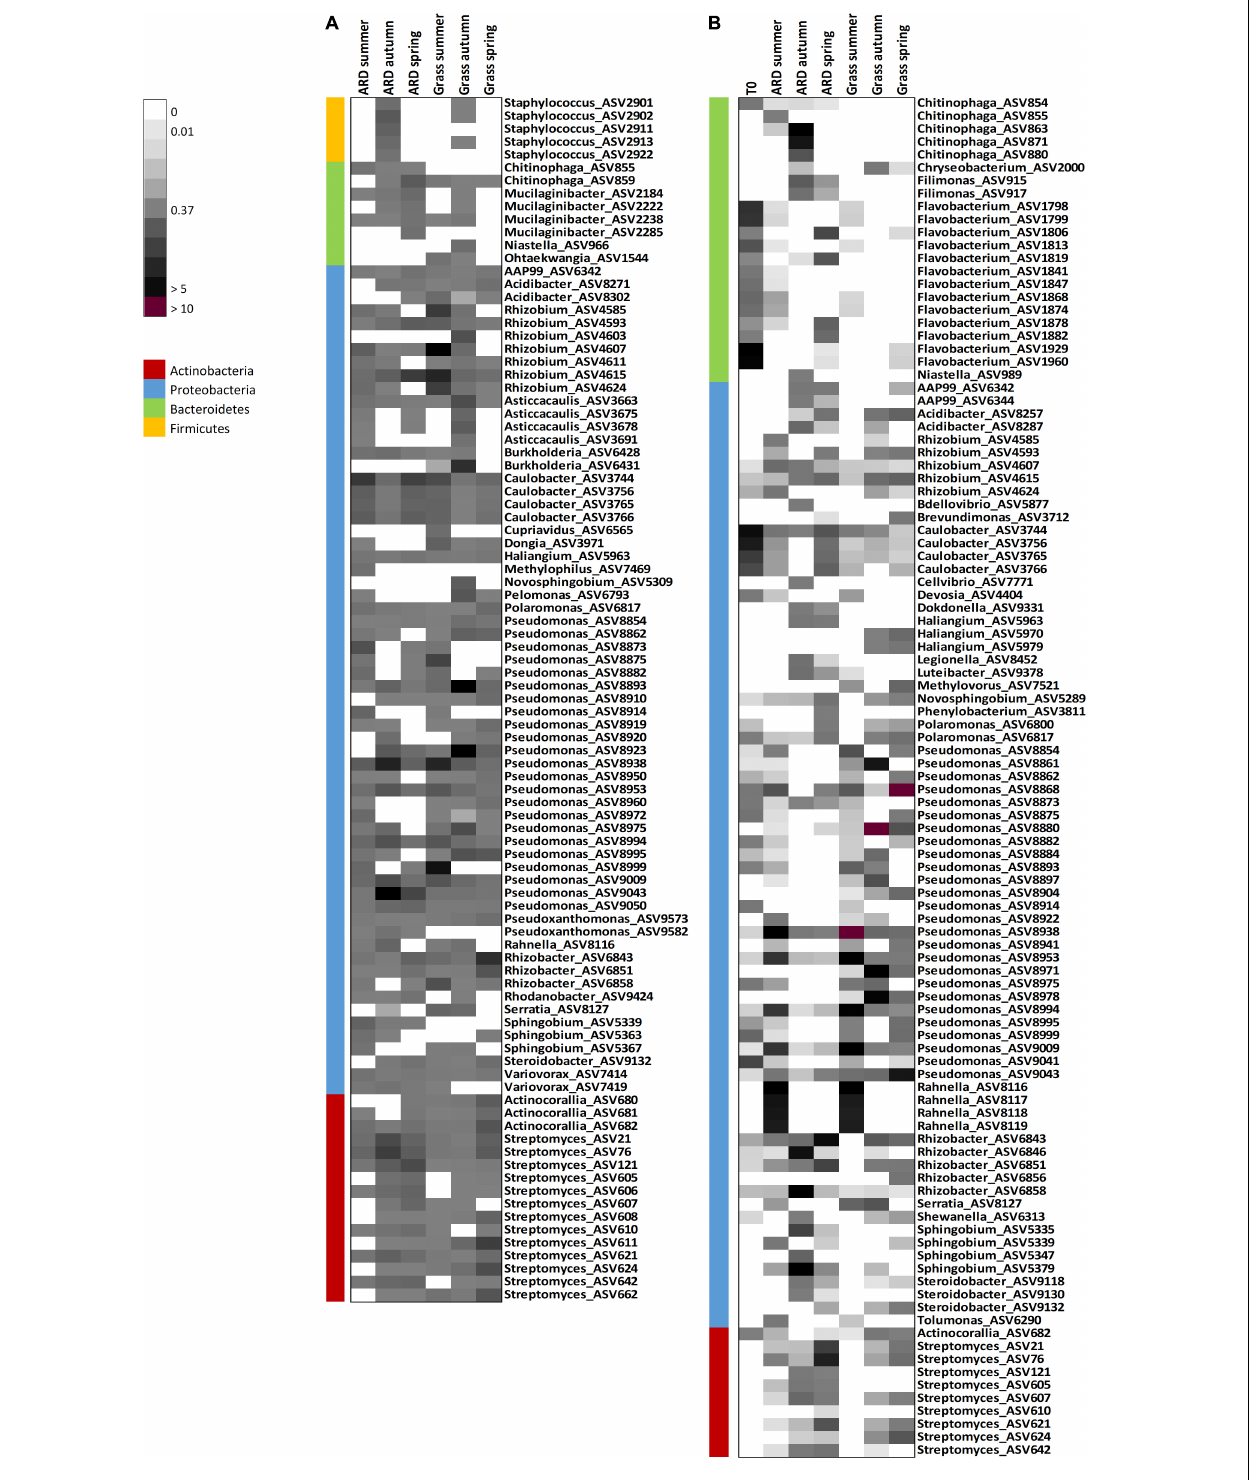
FIGURE 3 | Heatmap showing the abundance of different amplicon sequence variants (ASVs) (RA > 0.5%) in roots of Bittenfelder plants from ARD and grass plots taken 3 months (summer), 7 months (autumn), and 12 months (spring) after planting at Heidgraben (A) in 2016/17 and Ellerhoop (B) in 2017/18. For each sampling time per site and soil, only ASVs with an abundance greater than 0.5% were selected, and their relative abundance was compared with all other variants. The color code indicates the range from low relative abundance (light gray, 0.01%), medium abundance [gray, 0.37% (median)], to high abundance (black > 5%, purple > 10%). Different colors on the left side indicate the corresponding phylum of the